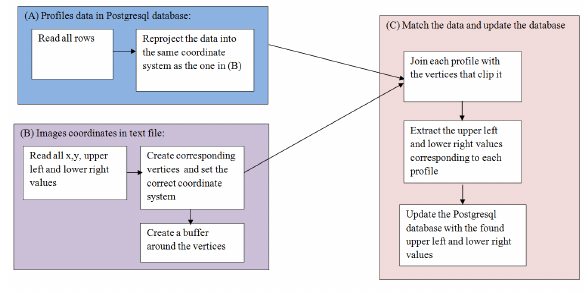
Figure 3: Steps of joining